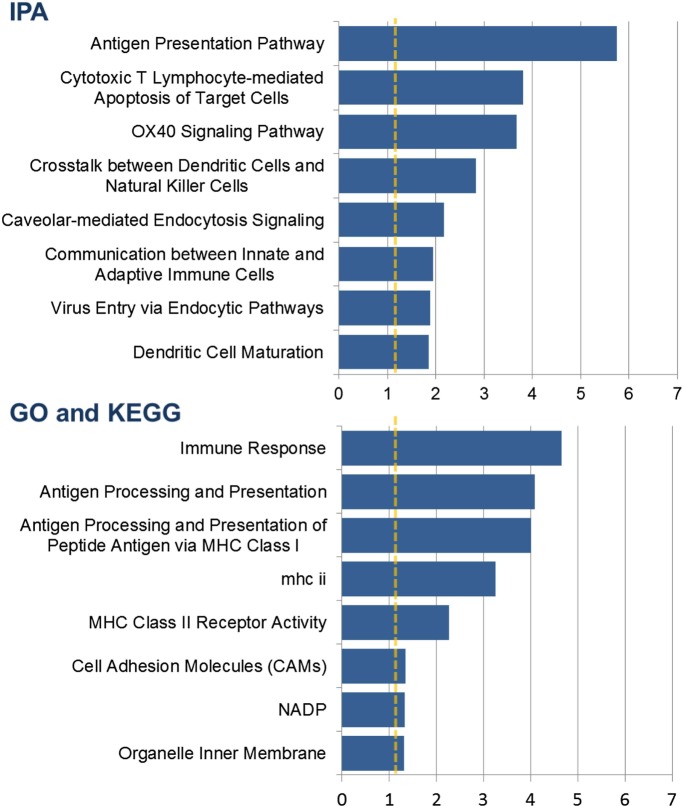
Content analysis shows enrichment for genes involved in membrane trafficking, antigen processing, and antigen presentation.Barplots show categories with significant overrepresentation in the list of 98 genes with a strong cis-eQTL and a response to vaccination expressed as either a transcriptional response or a change in the genetic effect in both cohorts. The negative log(p-value) is plotted on the x-axis.